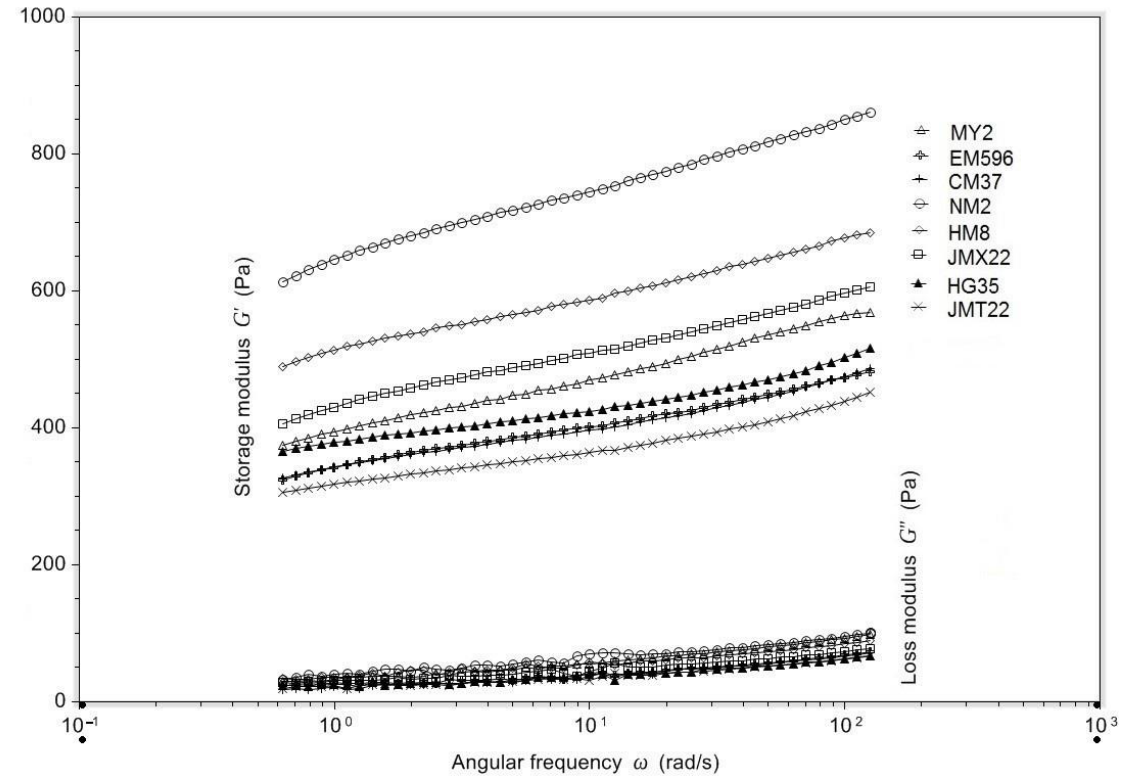
Figure 5. Dynamic rheological properties of starch from wheat varying in grain hardness.